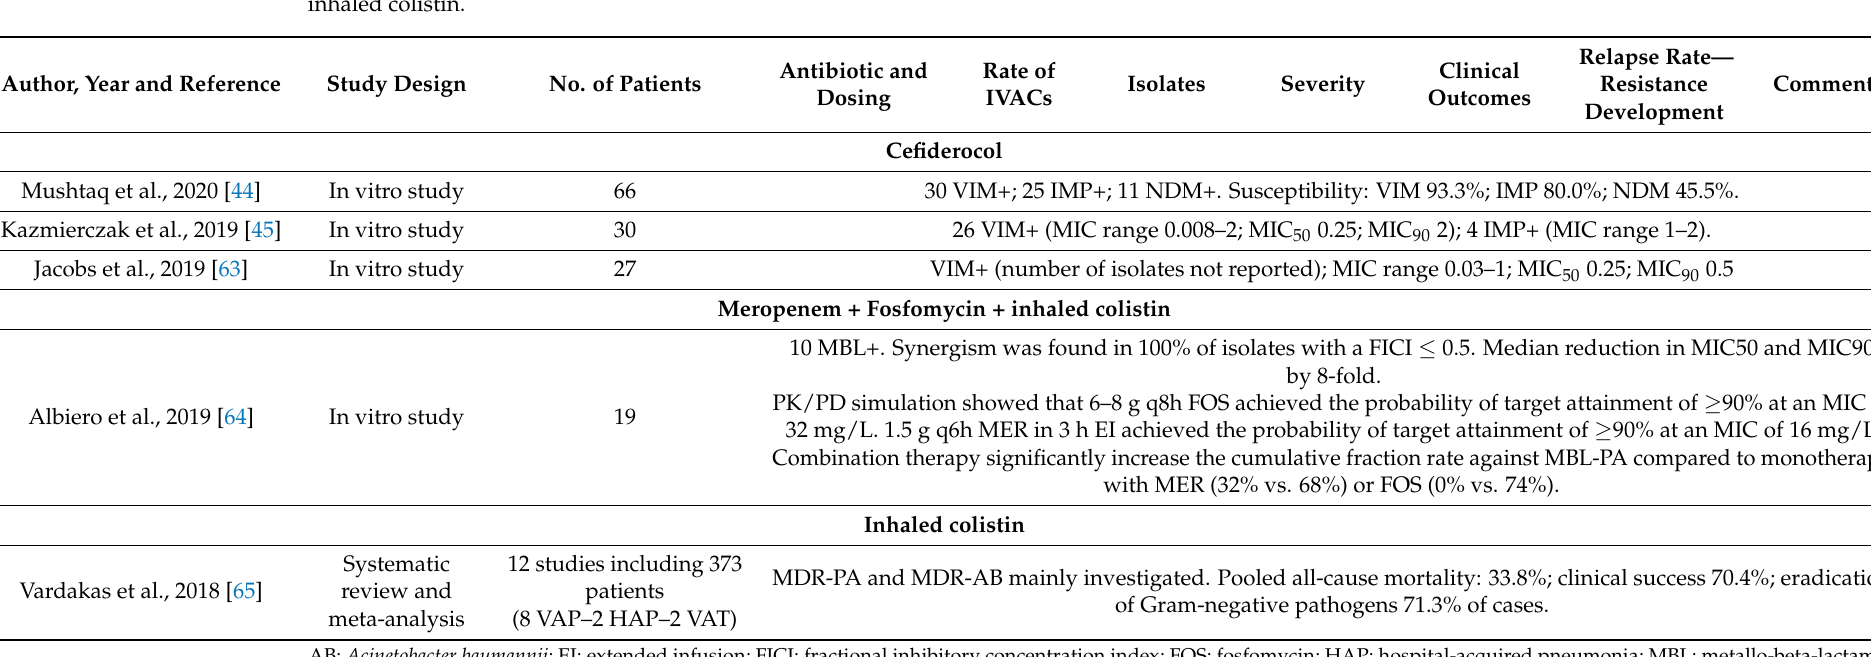
Table 4. Summary of the studies investigating the treatment of multidrug-resistant (MDR) metallo-beta-lactamase-positive Pseudomonas aeruginosa infection-related ventilator-associated complications (IVACs) with cefiderocol in association with inhaled colistin or combination therapy between meropenem, fosfomycin and inhaled